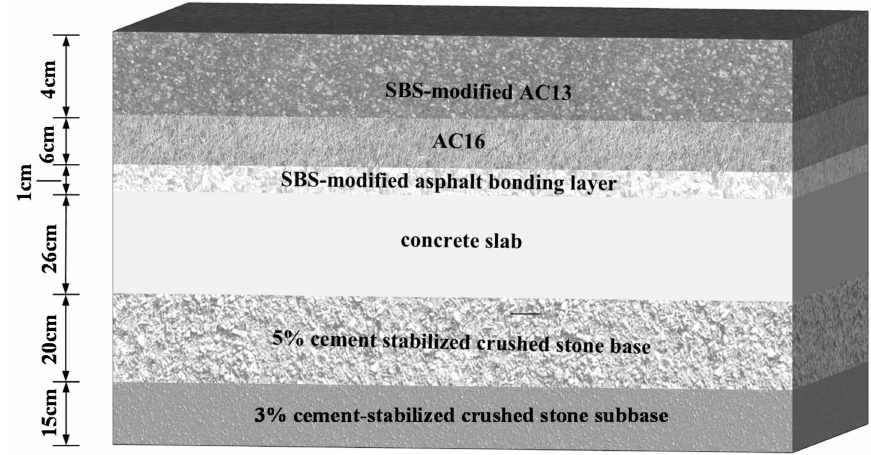
Figure 1. The layout of the continuously reinforced concrete pavement (CRCP) test section with basalt fiber-reinforced polymer (BFRP) bars.